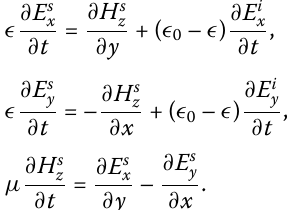
Assuming that the incident field is also a solution of Maxwell’s equations (4), with coef- ficients (cid:6) 0 and μ 0 = μ being the relative permittivity and permeability of the medium in which the incident field propagates in the absence of scatterers, we insert (6) into (4)